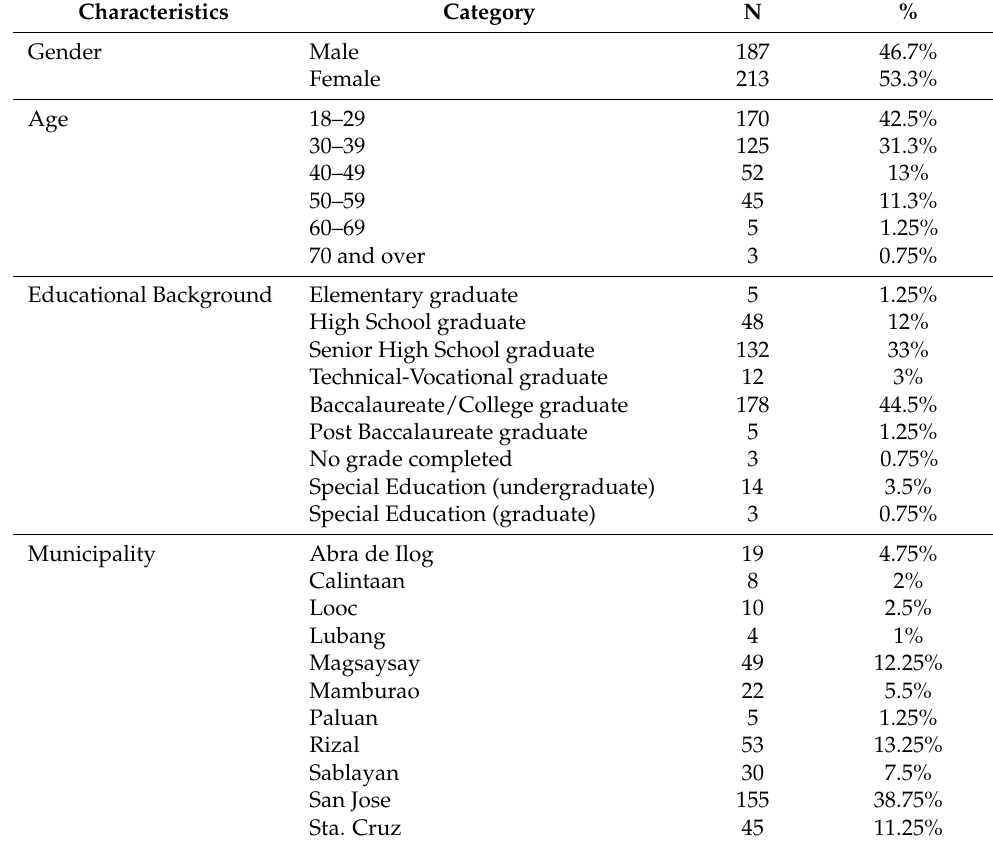
Table 1. Descriptive statistics of the participants ( n =